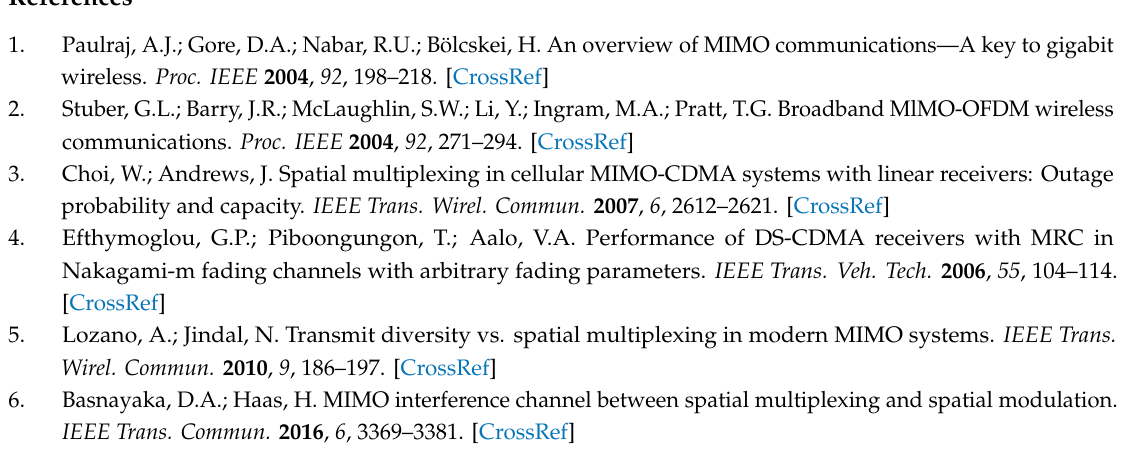
Figure 3. BER values for increased diversity order MIMO orientations.